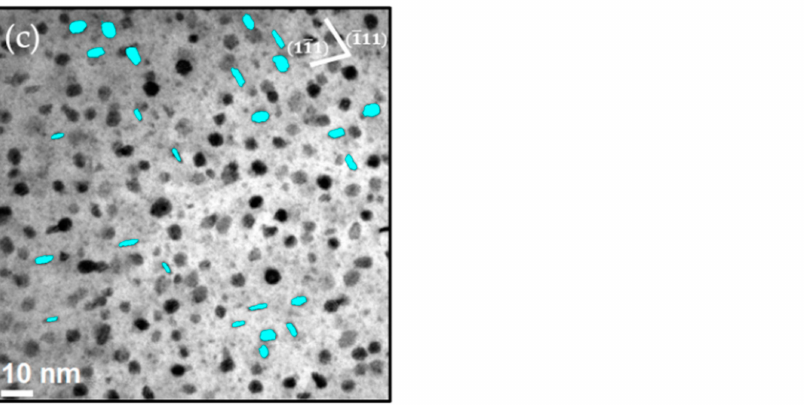
Figure 9. Statistically analyzing η (cid:48) precipitate images of 7075-HCu subjected to 120 ◦ C PA: ( a ) TEM image, ( b ) selected non-edge-on precipitates, and ( c ) selected edge-on precipitates. Table 4. Average sizes of η (cid:48) precipitate of 7075-LCu subjected to different PA conditions. Aging Temp.